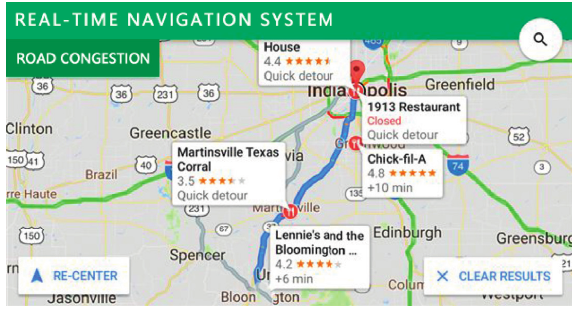
Figure 6: Traffic query